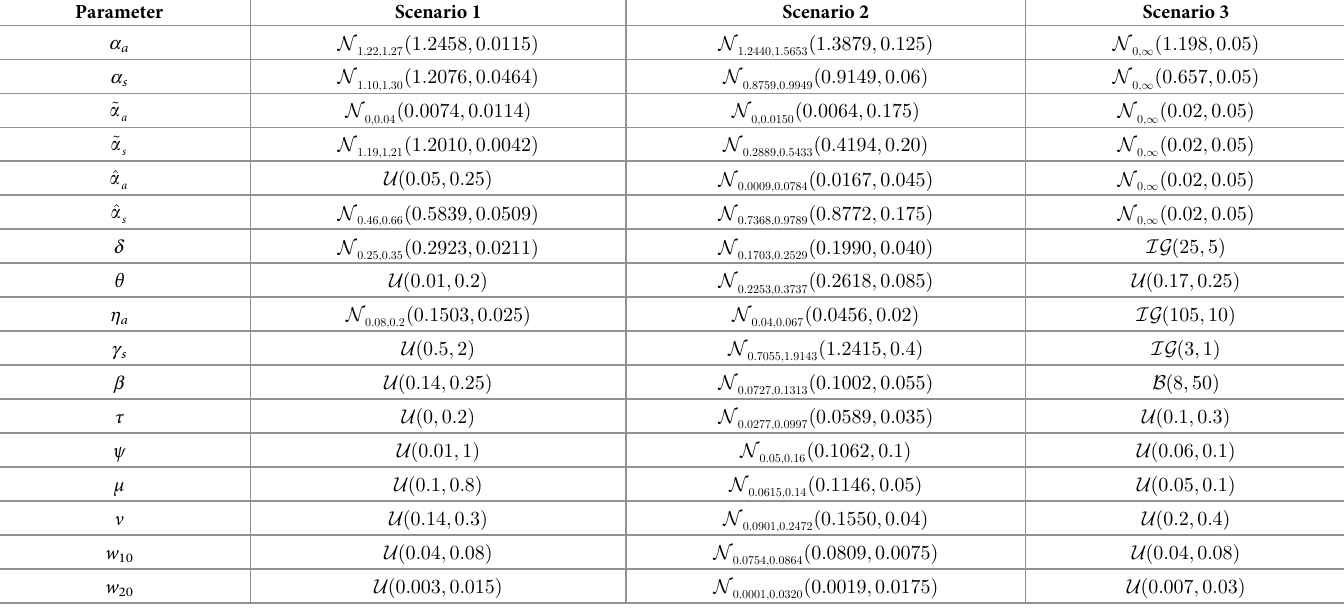
Table 2. Model parameter distributions.